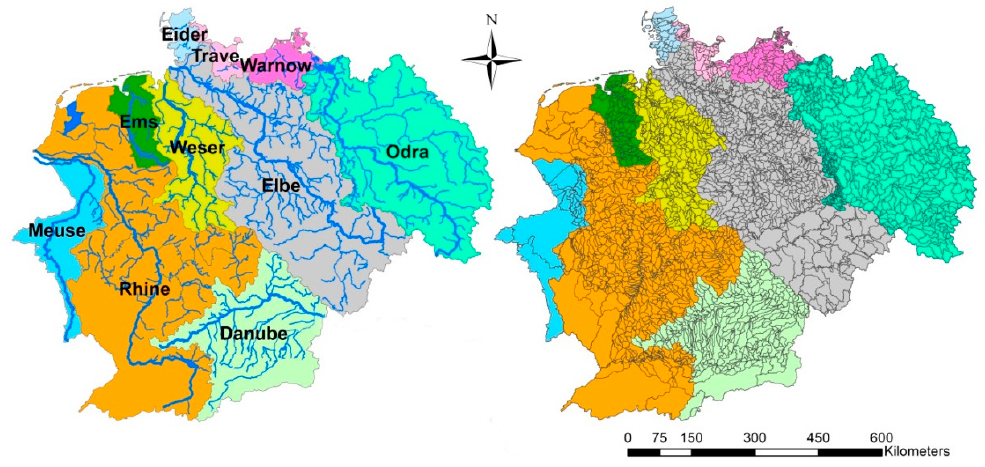
Figure 3. River basins covered by the currently largest MoRE application ( left ) and their corresponding analytical units ( right ).